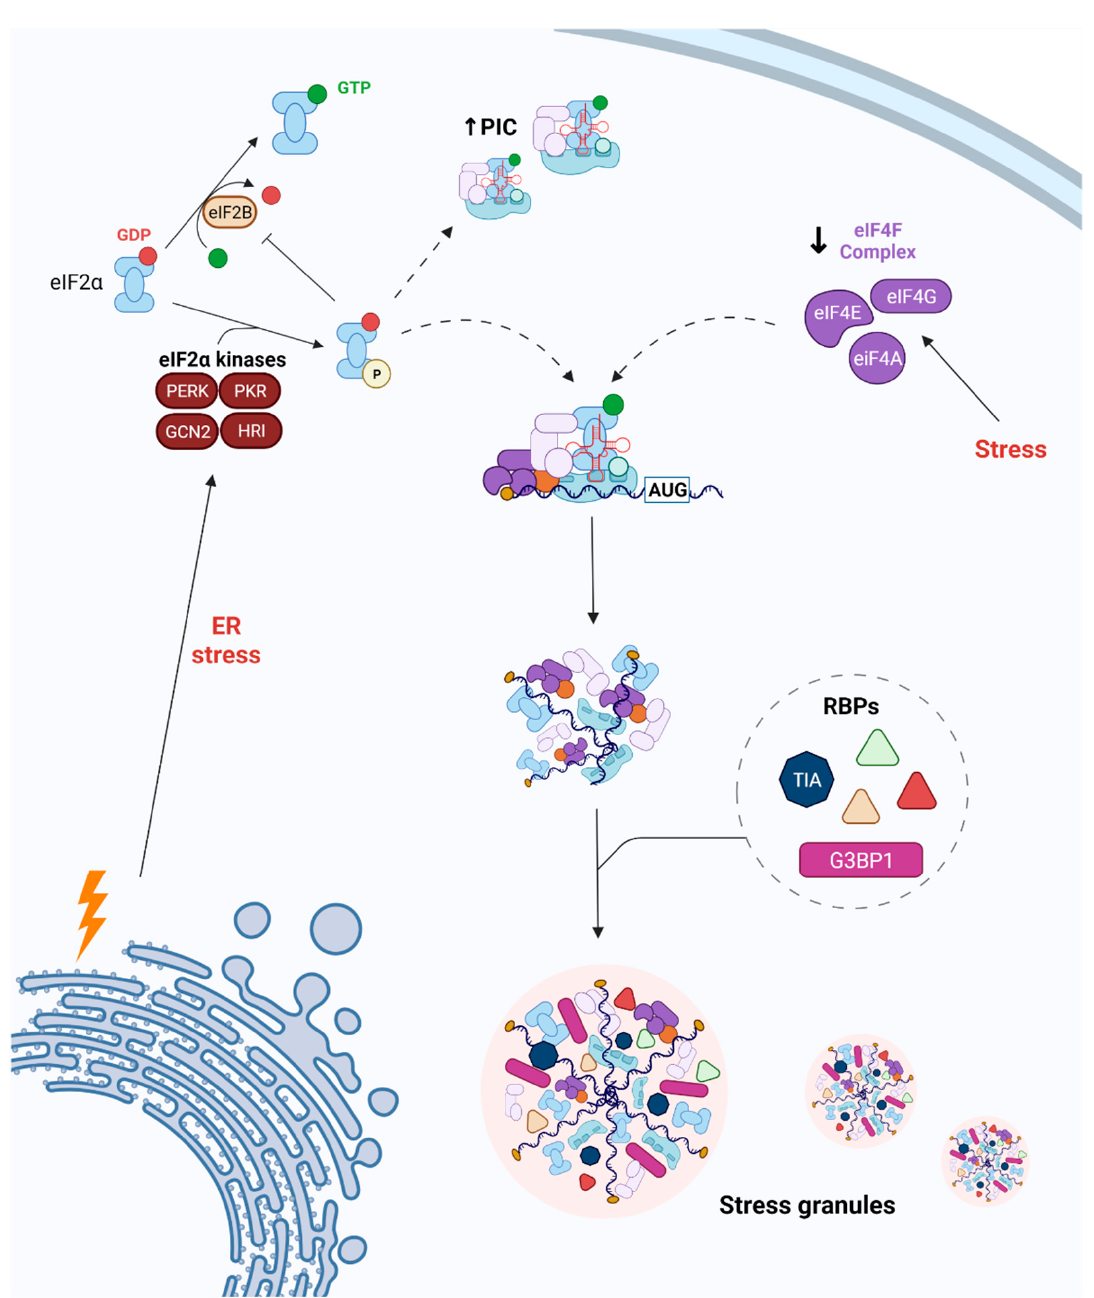
Figure 2. The phosphorylation of eIF2 α and disassembly of the eIF4F complex are the main pathways blocking protein translation in cases of endoplasmic reticulum (ER) stress. The kinases PERK, PKR, GCN2, and HRI can phosphorylate and, therefore, inhibit eIF2 α . In both cases, RNA-binding proteins (RBPs) such as TIA1 or G3BP1, among others, interact with the incomplete PIC and promote SG formation (dashed arrows). Importantly, the nucleated SGs mature by adding other RBPs that attach to existing mRNAs and/or bring new mRNAs.